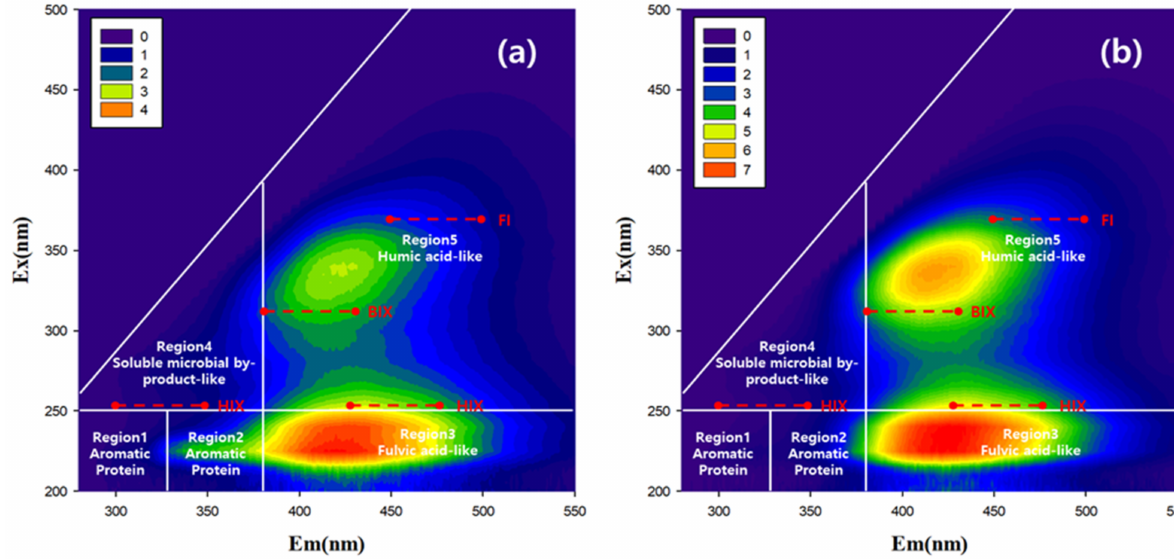
Figure 6. T1 area ( a ) and swine wastewater treatment effluent. ( b ) EEM results and the five regions of EEM based on literature reports